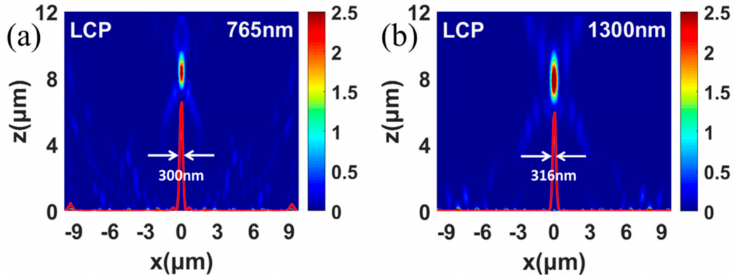
Figure 7. Simulated intensity distributions in the X–Z plane of achromatic metalens under the LCP incidence with the wavelength of 765 nm ( a ), and 1300 nm ( b ). The red curves show the concrete profiles of the FWHMs of the